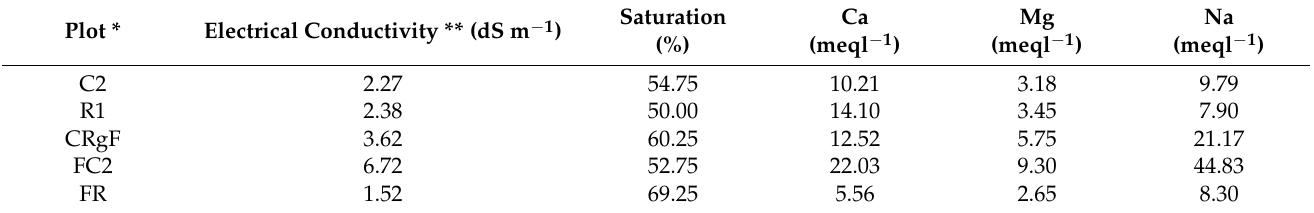
Table 4. Additional soil analysis data for the fields that had higher salinity